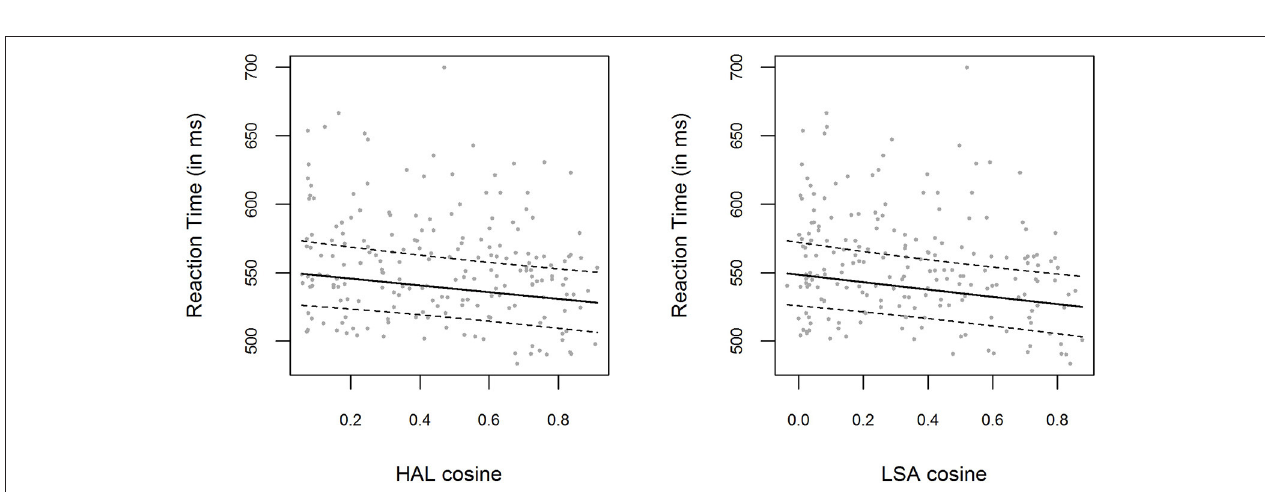
FIGURE 2 | (Left panel) Mean RTs for each item in Experiment 2, plotted as a function of the prime-target HAL cosine similarity. The solid line shows the exponentiated model predictions of the model including cosine fixed effects, with the corresponding 0.95 confidence interval (dashed line). (Right panel) Mean RTs and model predictions, as in the left panel, for LSA cosine similarities.